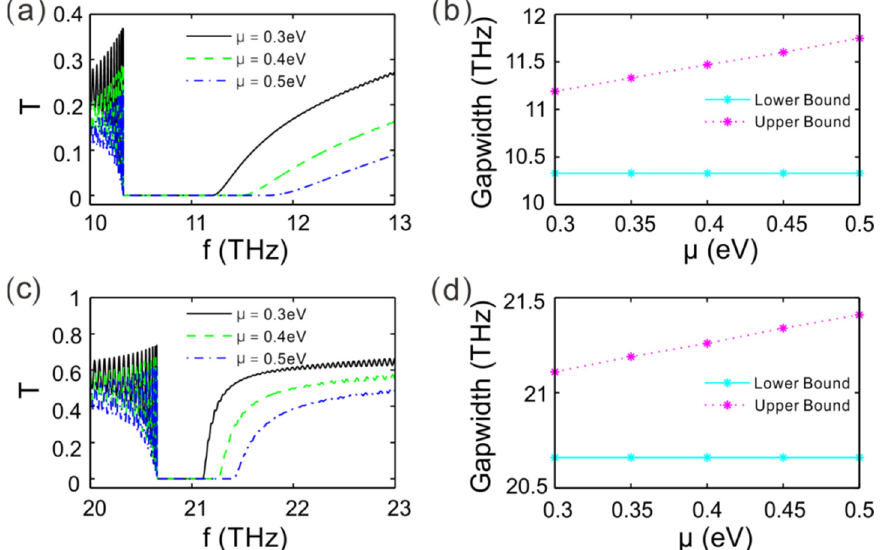
Figure 3. ( a ) Transmittance around the first bandgap for different values of graphene chemical potential. ( b ) The first stopband gapwidth varying with the chemical potential. ( c ) Transmittance around the second bandgap for different values of chemical potential. ( d ) Gapwidth of the second stopband varying with the chemical potential.